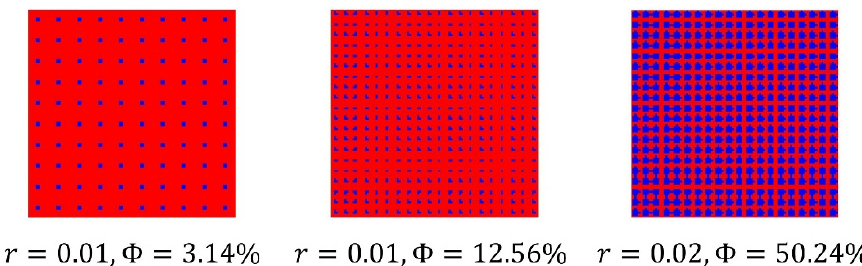
Figure 2. Uniform distribution void defects with different volume fractions.